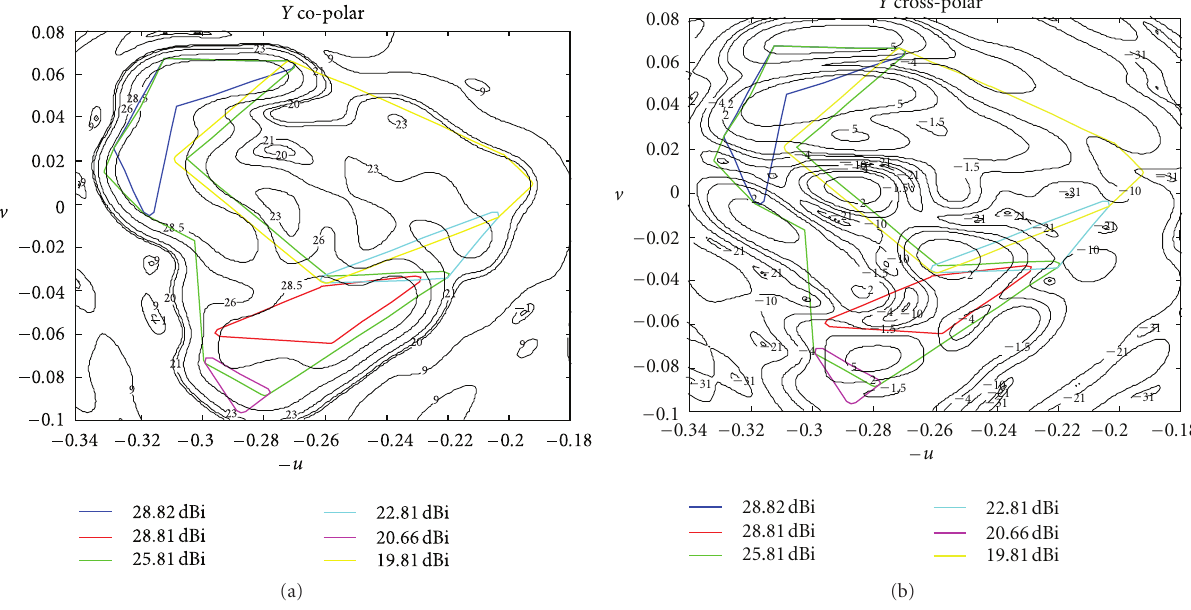
Figure 12: Radiation patterns obtained by MoM for a two-layer reflectarray in Tx band, 11.95 GHz. (a) Copolar component. (b) Crosspolar